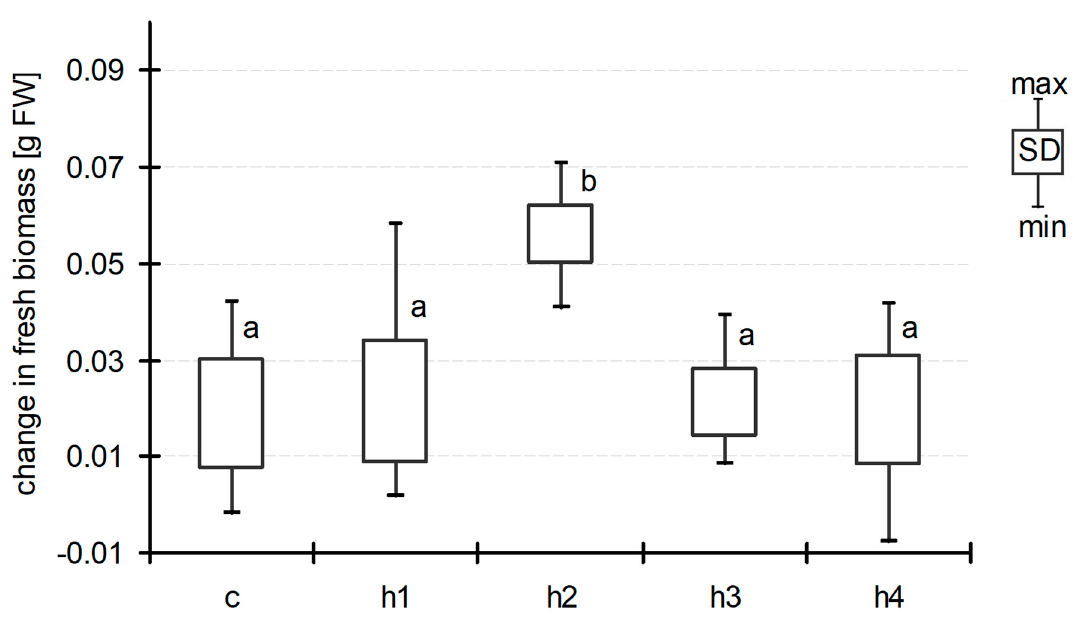
Figure 1. Change in biomass of Lemna minor between D01 and D07 (means with the same letters did not differ significantly; post hoc Duncan’s test at p < 0.05).